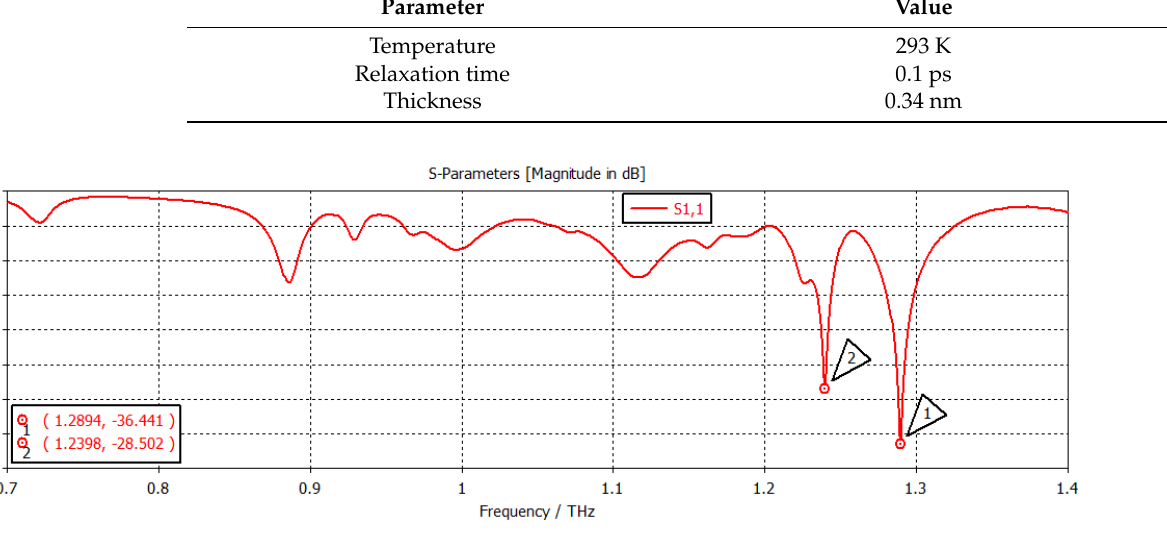
Figure 6. Chemical potential = 0.1 eV.